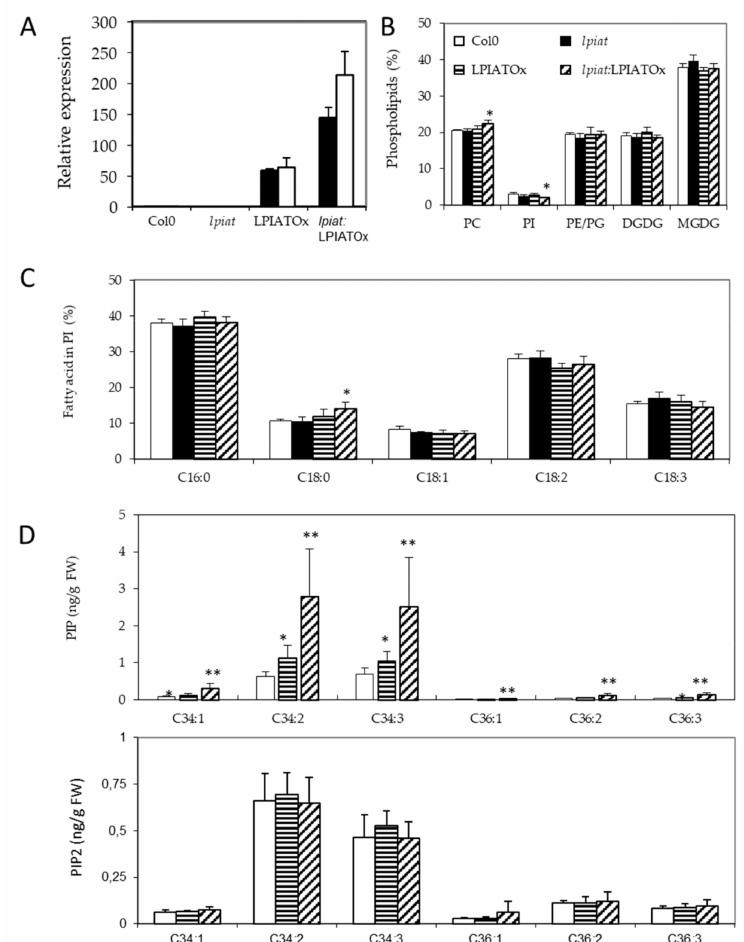
Figure 5. Impact of LPIAT on lipid metabolism. ( A ), Relative quantification of LPIAT expression in wt, lpiat , LPIATOx (overexpression in wild-type background) and lpiat :LPIATOx (overexpression in knock-out background) in leaves from 1 week-old plants, normalized to two reference genes (actin and eIF4A-1). Relative expression quantities are represented related to wild type level at 1 week, which was set to one. Values represent mean ± SD of three technical replicates for two biological replicates (black and white boxes). ( B ), Phospholipid analysis of wt, lpiat or overexpressing leaves. Lipids from leaves from 3 week-old plants were quantified by GC-FID after transesterification. Values represent mean ± SD for four biological replicates. ( C ), Phosphatidylinositol (PI) fatty acid composition (in % of total FA). Values represent mean ± SD for four biological replicates. ( D ), E ff ect of LPIAT overexpression on the molecular fatty acid composition of PIP (top panel) and PIP2 (down panel) in leaves. Phosphoinositides were extracted from leaves from 3-week-old plants by acidic extraction and analysed by LC MS / MS after derivatization. Values represent mean ± SD for five biological replicates. Statistically significant di ff erences from the wild type are indicated by * p < 0.05 or ** p < 0.01 as determined by Wilcoxon’s-test. On the contrary, the phosphatidylinositol bisphosphate (PIP2) content remained unchanged whatever the lines. C34:2 and C34:3 species are the major phosphoinositide detected in both PIP and PIP2 pools (in PIP, 43.0% and 46.5%; in PIP2, 46.7% and 32.5%, respectively). C16:1 fatty acid is almost only associated with plastidial phosphatidylglycerol in plants, C16:2 is quasi absent in leaf tissues, C16:3 is only associated with MGDG, and because C18:2 and C18:3 are the major fatty acids [43],